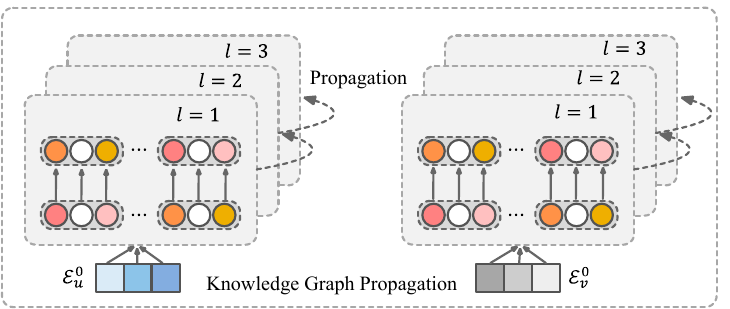
Figure 4. Structural diagram of knowledge graph propagation. The initial set of entities is similar to a sound wave source that propagates information layer-by-layer, from near to far, in the knowledge graph. Higher-order interaction information features of users and items are obtained via propaga- tion.